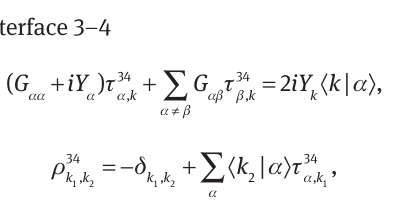
loops containing these regions can be expanded into the different combinations of the guided modes considered. Furthermore, plan waves in region 3 can propagate as diffraction orders of the periodic system, as described by the indices of the reflection and transmission coefficients 34 Every loop containing this region, i.e. f , f , f , and f , must be expanded into combi- 23 13 24 14 nations of diffraction orders both coming back and forth. In Figure 3B, an example of the different loop combina- tion of f is given for orders – 1, 0, + 1. 23